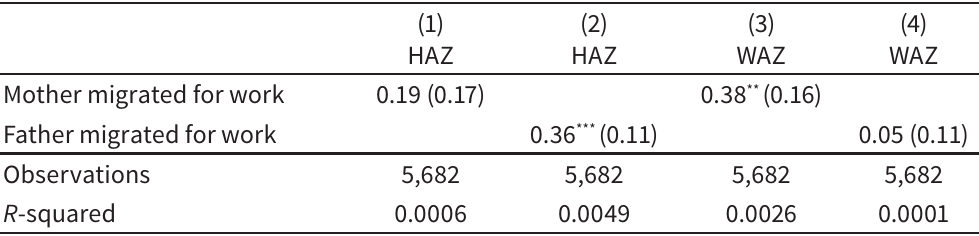
Uncontrolled regression